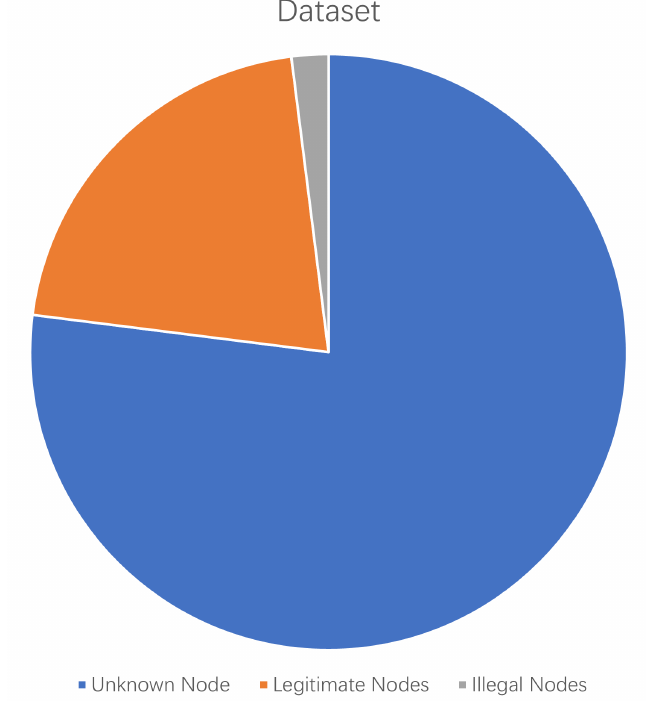
Figure 2. The proportion of different nodes in the data